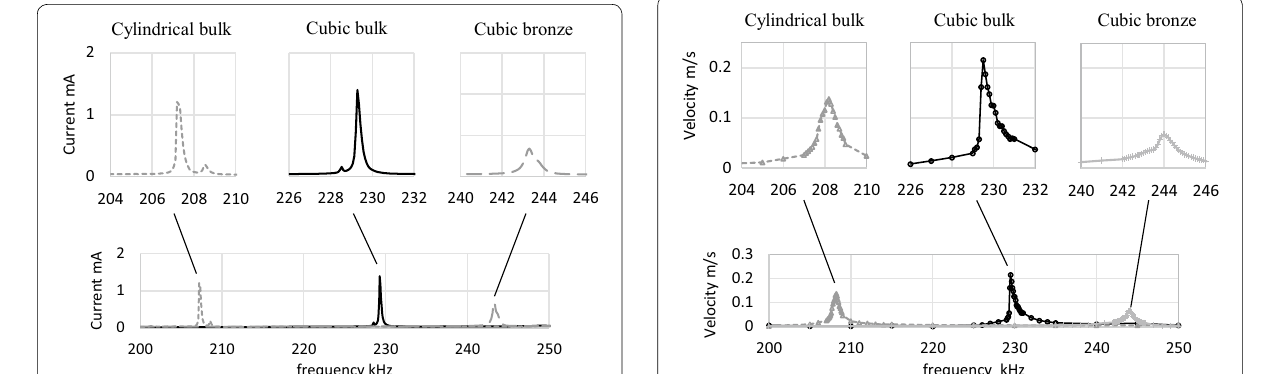
Fig. 4 Frequency characteristic of the current measured by impedance analysis